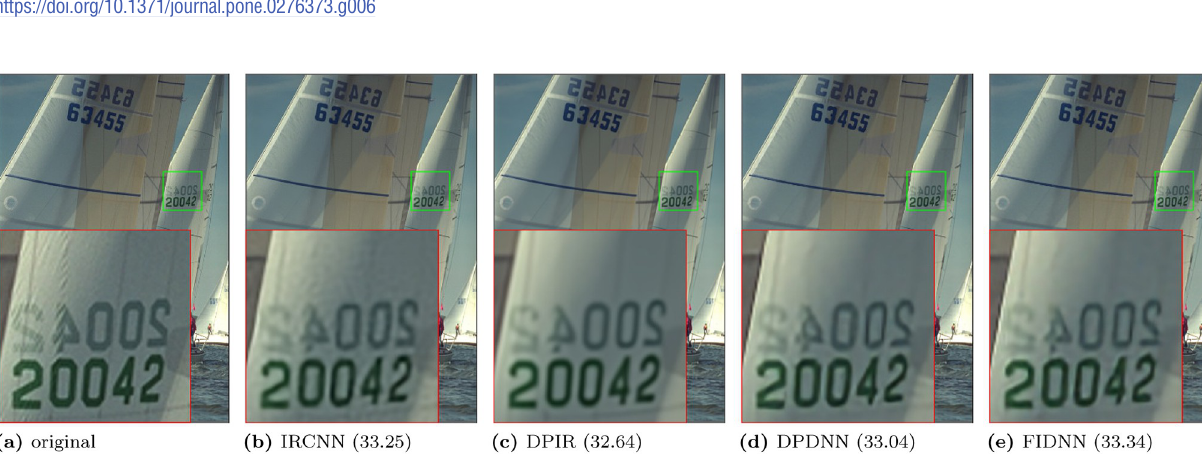
Fig 7. Gaussian deblurring results for standard deviation 1.6 and noise level 2 on ‘kodim19’ image from Kodak24 dataset. (a) original. (b) IRCNN (33.25). (c) DPIR (32.64). (d) DPDNN (33.04). (e) FIDNN (33.34).